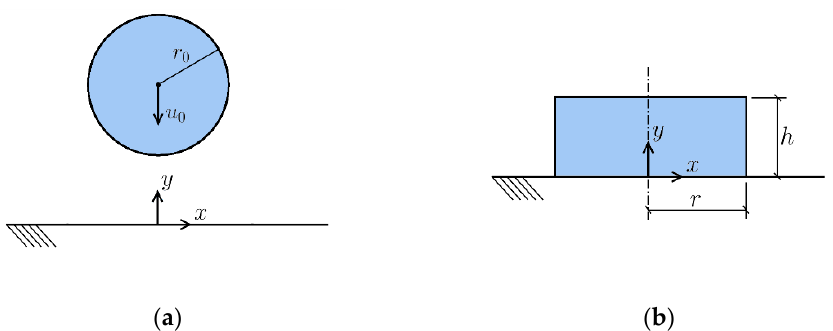
Figure 1. Droplet evolution sketch, following [13], and coordinate system. ( a ) impinging droplet, ( b ) shallow cylinder approximating the droplet shape during the spreading and retreat phase.